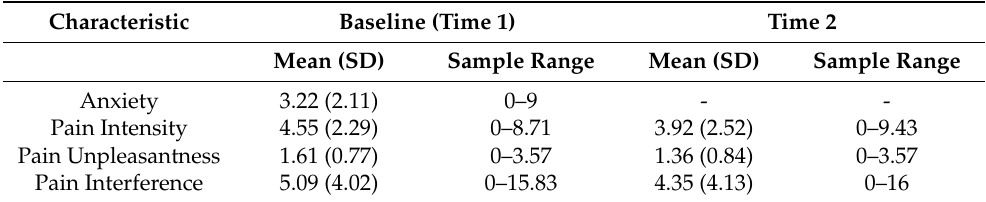
Table 2. Average daily pain and anxiety characteristics of the